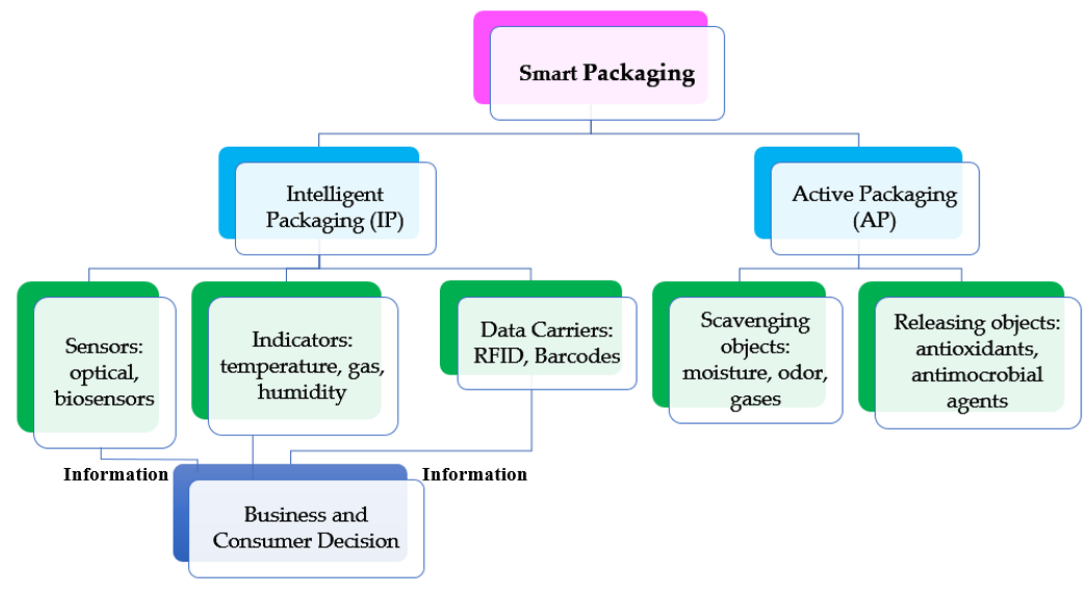
Figure 2. Smart packaging system